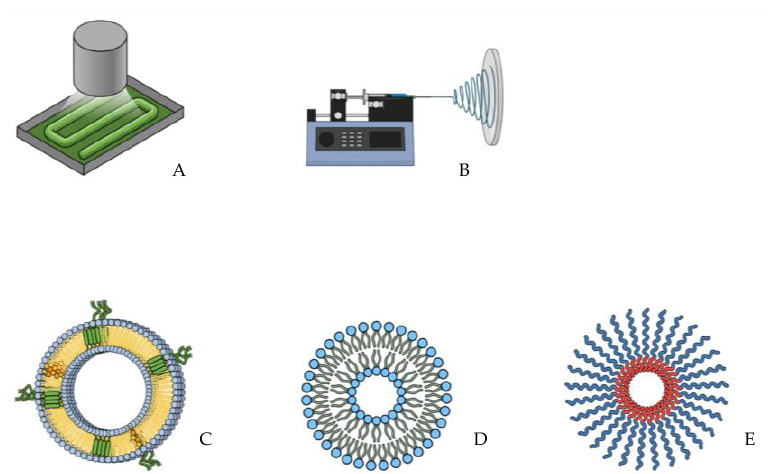
Figure 1. Examples of techniques and drug delivery systems tested in regenerative medicine: ( A ) 3D Bioprinting, ( B ) Electrospinning, ( C ) Extracellular vesicles, ( D ) Liposome, ( E ) Polymeric micelles.